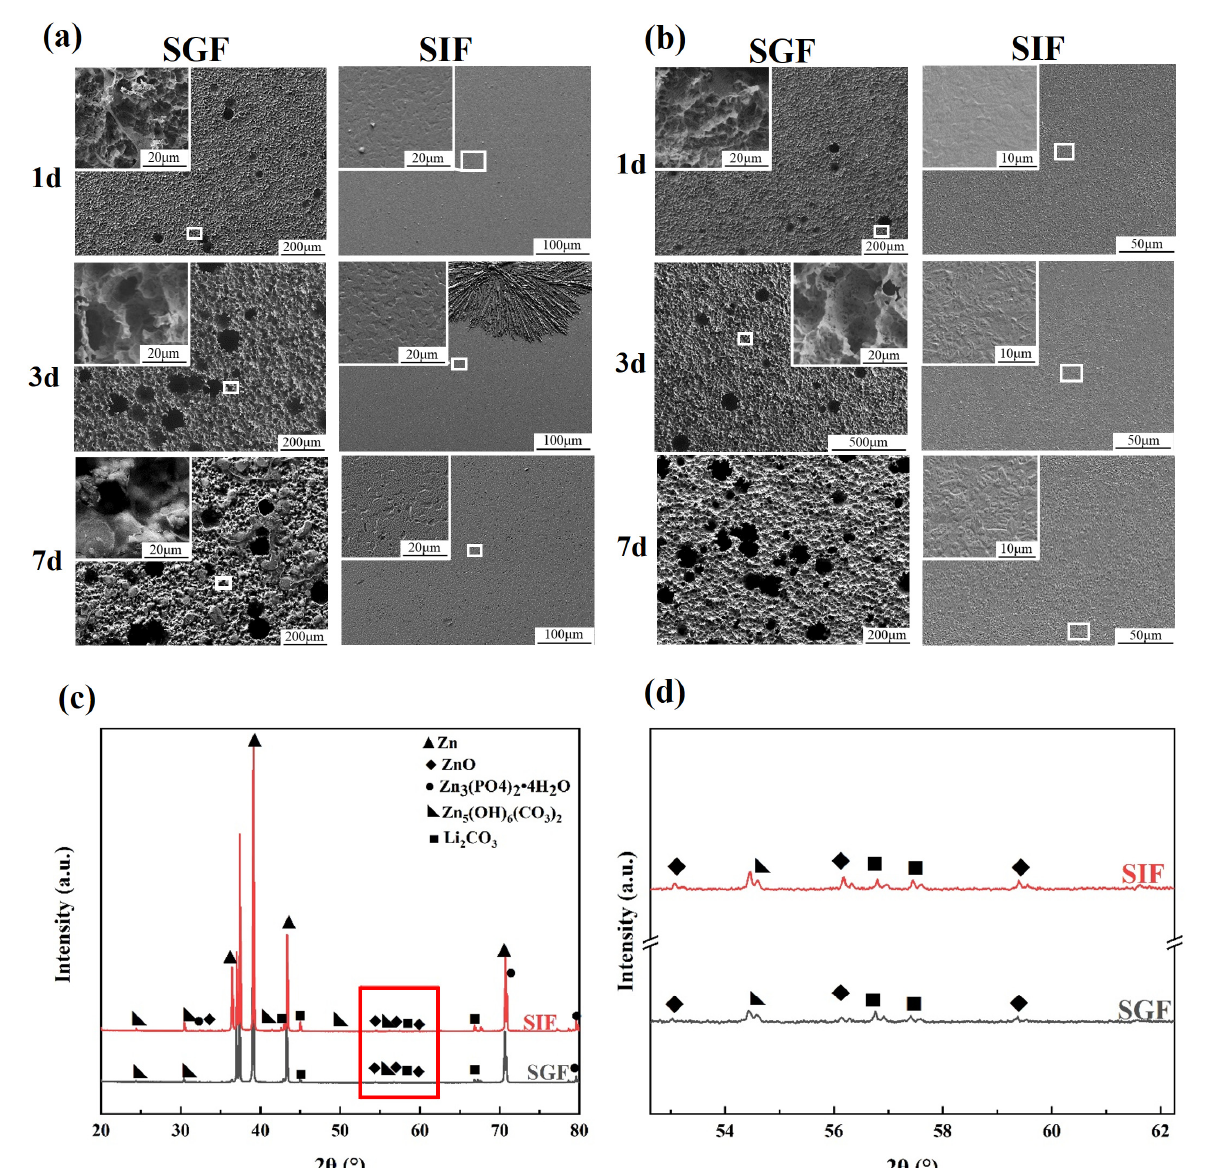
Figure 3. In vitro degradation behaviors of Zn–0.4Li alloy in SGF and SIF. ( a ) SEM images of Zn– 0.4Li immersed in SGF and SIF at different time, and ( b ) surface morphologies after the removal of corrosion products. The areas enclosed by white squares are observed at high magnification. ( c ) XRD analysis of degradation products. ( d ) Enlarged image of the red frame.